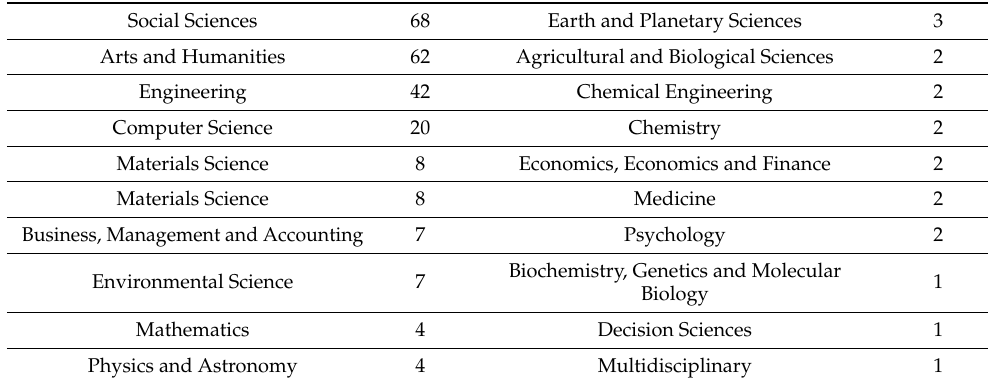
Table 2. SCOUPS subject statistics on public art and materials-related